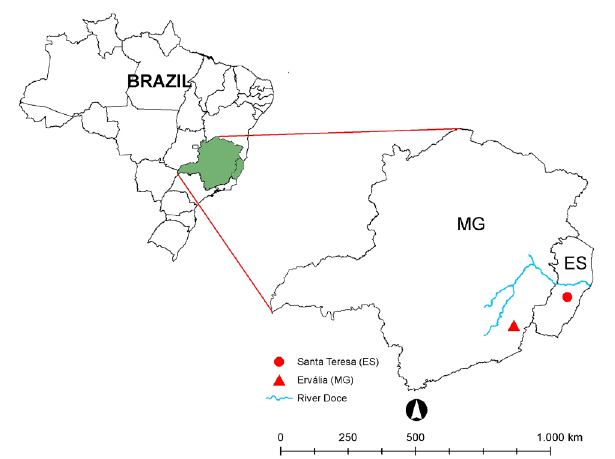
Figure 1. Leptodactylus cupreus Adult male of (MBML 6844) from municipality of Santa Teresa, state of Espírito Santo, Brazil. Photo by J.